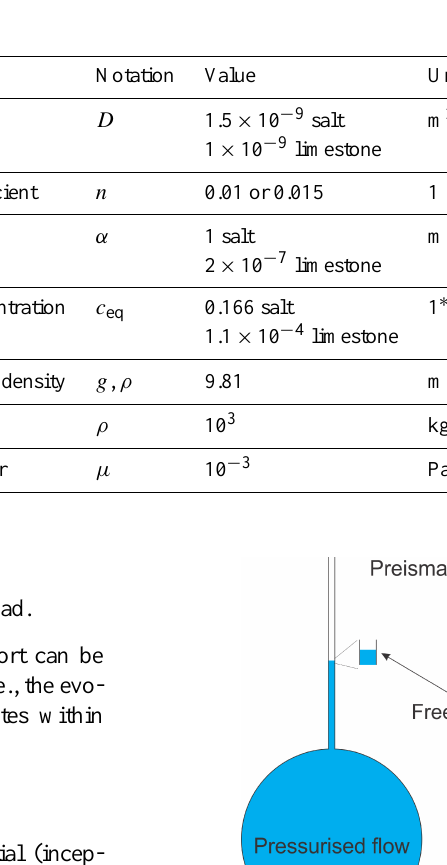
Table 1. List of rate constants and other parameters used in this work. ∗ To have dissolution rates expressed as a velocity of wall retreat, concentration [NL − 1 ] is multiplied with molar mass [MN − 1 ] and divided by the density [ML − 3 ] of the mineral forming the rock and being dissolved. This makes c eq dimensionless.